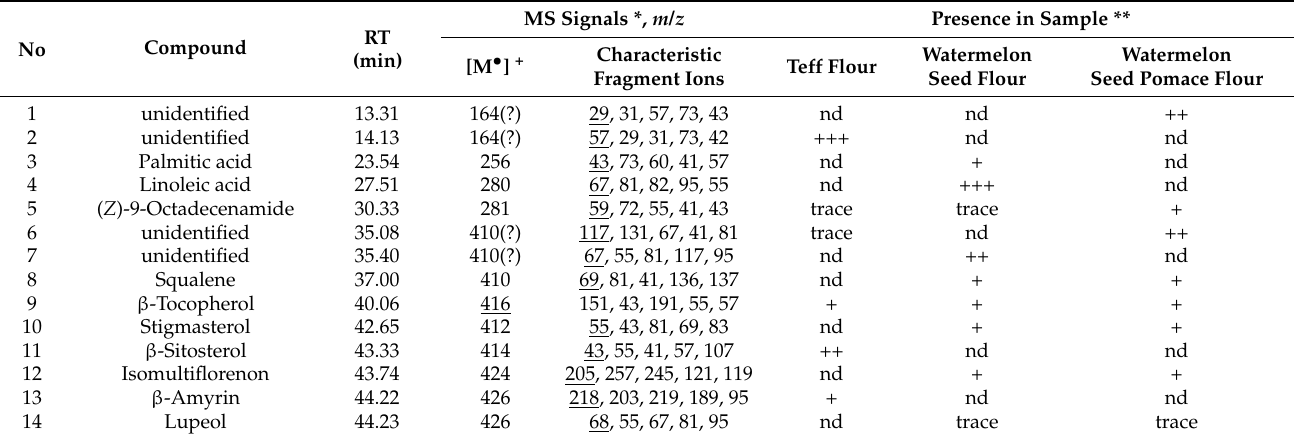
Table 4. Compounds identified in methanolic extracts of teff and watermelon flour samples by GC-MS